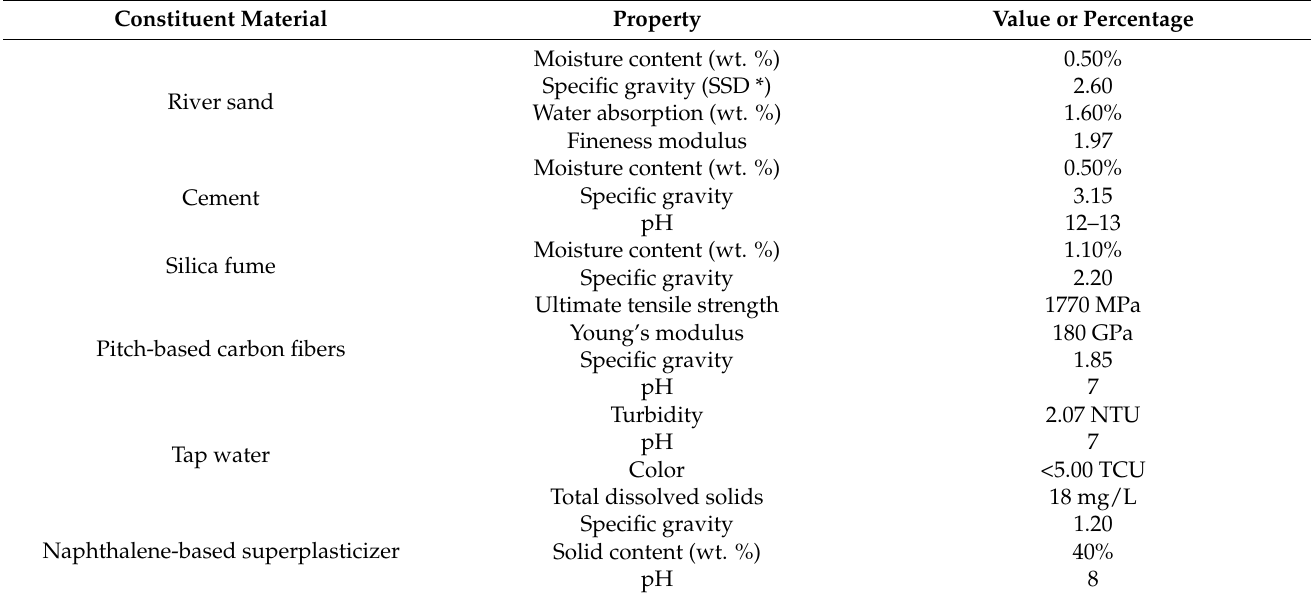
Table 1. Properties of the constituent materials of the mortar